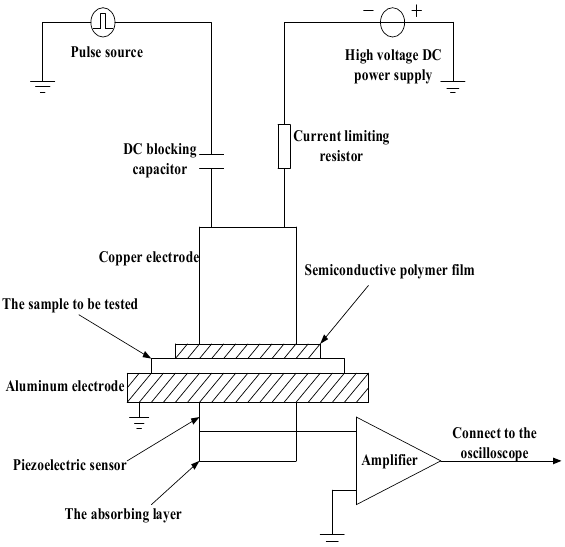
Figure 1. The space charge testing system.